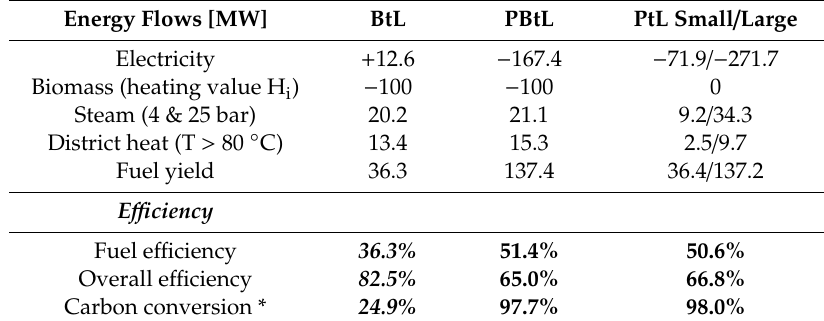
Table 1. Model results for the energy flows of a reference plant with 100 MW th biomass input, reproduced with permission from [11].